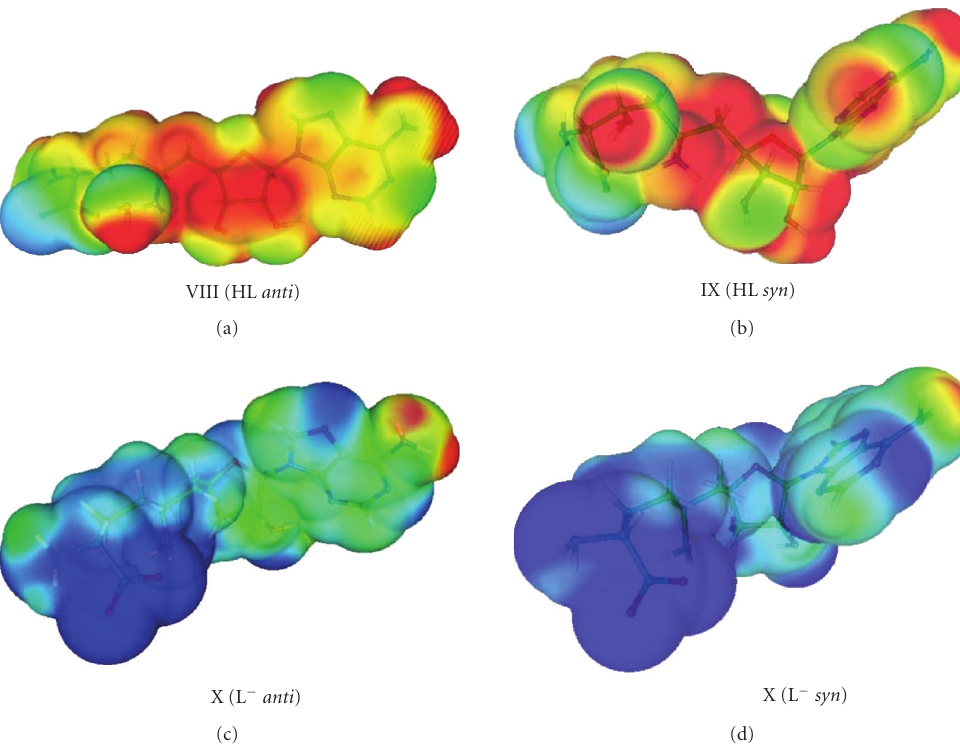
Figure 9: Electrostatic potentials of HL and L − in the syn and anti conformations. The potential values are in the range from − 0.012 [a.u.] (blue) to 0.05 [a.u.]